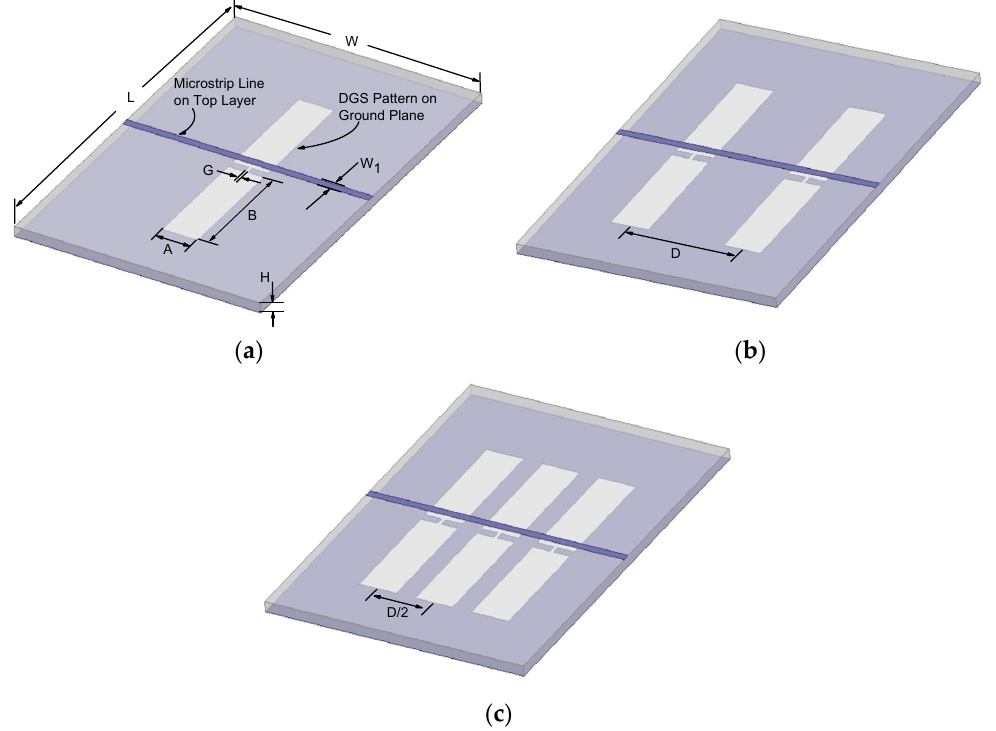
Figure 1. 3-D model of ( a ) one-, ( b ) two- and ( c ) three-DGS structures.